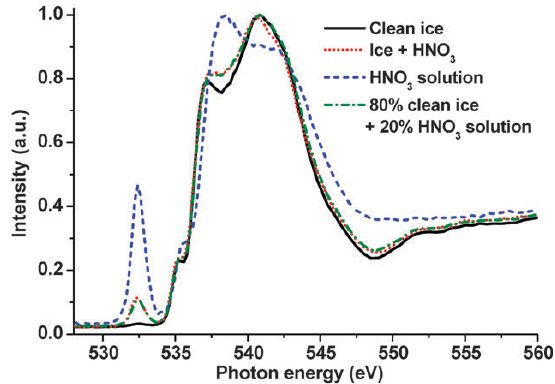
Fig. 9. NEXAFS spectra probing the oxygen of nitrate and ice at the surface at the upper few nanometres of the sample and showing little change to the structure of ice in the presence of adsorbed nitrate (red dotted line) compared to pure ice (black solid line) at 230K. Reproduced from Kˇrepelová et al. (2010b) with permission from the PCCP Owner